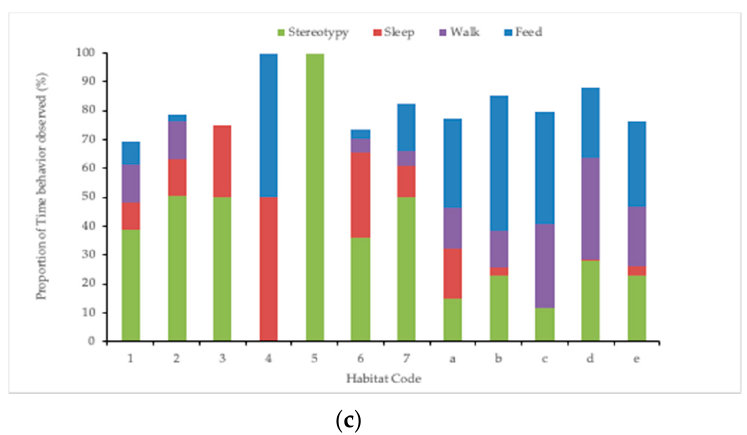
Figure 8. Activity budget representing proportion of time spent exhibiting four key behaviors: “Stereotypy”, “Sleep”, “Walk”, and “Feed”. Observations made on three elephants through 24 h interval monitoring are represented and include: ( a ) Ambika, ( b ) Swarna, and ( c ) Spike. Habitats include indoor suites 1–7 and Elephant Community Center and outdoor habitats a–e.